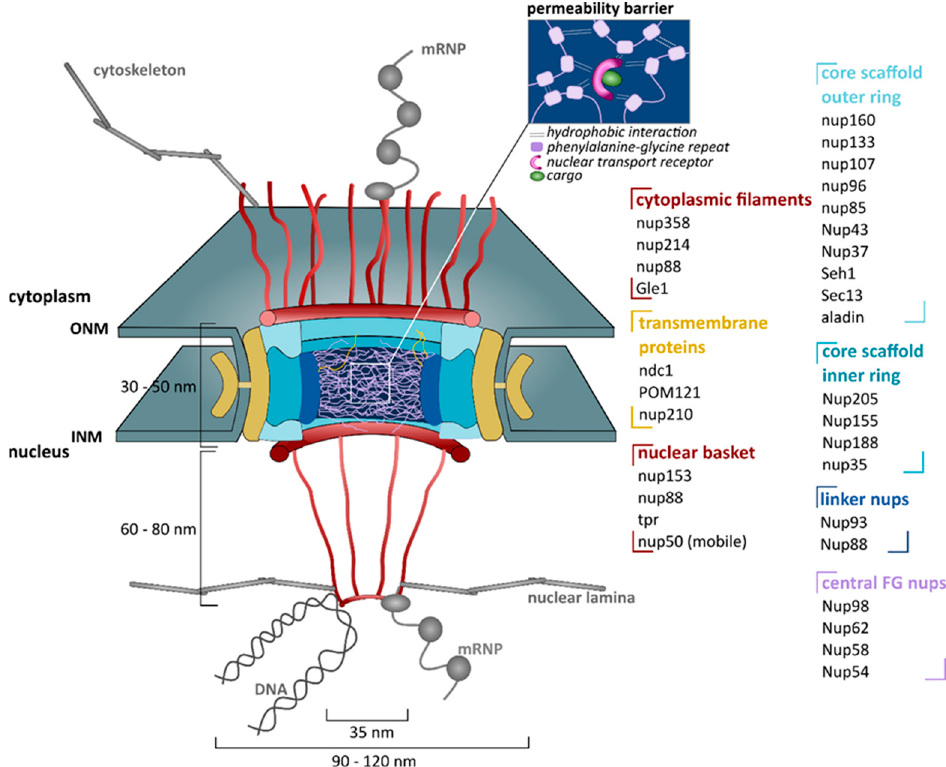
Figure 1. Structural organization of the nuclear pore complex. Nuclear pore complexes (NPCs) reside in circular openings in the nuclear envelope where the outer and inner nuclear membrane (ONM and INM, respectively) fuse. An NPC consists of different proteins called nucleoporins (nups), which are grouped in subcomplexes. Transmembrane nucleoporins anchor the NPC in the nuclear membrane. They connect to the core scaffold that exists of an outer ring and an inner ring. Linker nucleoporins anchor phenylalanine-glycine nucleoporins (FG nups) to the core scaffold, such that they line and fill the central tube. There, they phase separate into a dense polymer meshwork, which forms a highly selective permeability barrier. Peripheral structures consist of cytoplasmic filaments and a nuclear basket. Cytoplasmic filaments connect to the cytoskeleton and to the protein synthesis machinery. The nuclear basket connects the NPC to aspects of nuclear metabolism, such as mRNA biogenesis and genome organization. ndc1: nuclear division cycle protein 1, pom121: pore membrane protein 121, tpr: translocated promoter region, seh1: Sec13 homologue 1. NPC structure is based on the reviews of Strambio-De-Castillia et al. [61] and Juhlen and Fahrenkrog [62]. Image of the permeability barrier is based on the review of Kim and Taylor [63].